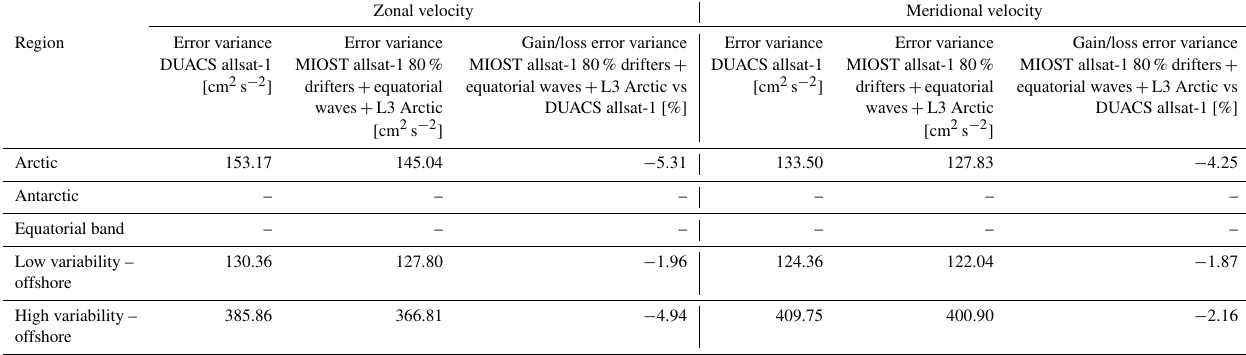
Table 9. Regionally averaged mapping error variance and gain/reduction of error variance on the surface currents between MIOST allsat-1 80% drifters + equatorial waves + L3 Arctic and DUACS allsat-1.